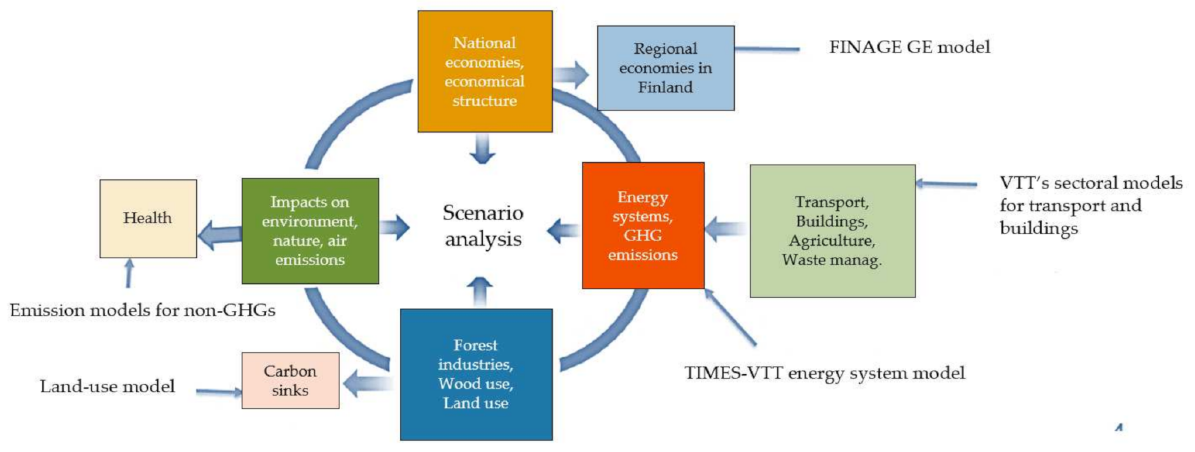
Figure 5. Finland’s scenario modelling framework to study the impact of policies.